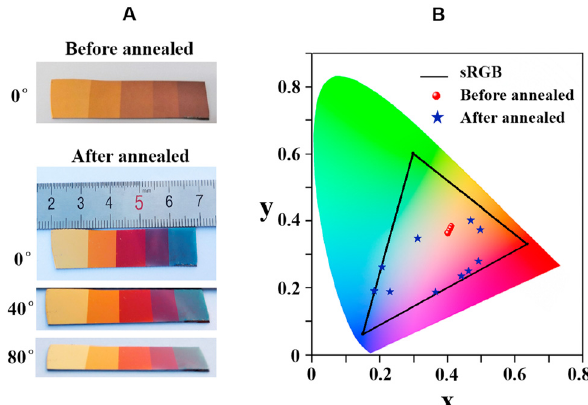
Figure 6: Angular responses of the color effects. (A) Top panel: A photograph of a series of Cu/Au intermediate structures (before annealed). Bottom panel: Photographs of a series of CuO/Au nanostructures(afterannealed)takenatdifferentangles.(B)TheCIE 1931 chromaticity coordinates of the colors generated by our structures. Solid symbols and stars are the results of Cu/Au intermediate structures (before annealed) and CuO/Au nanostructures (after annealed), respectively. The black line denotes sRGB color